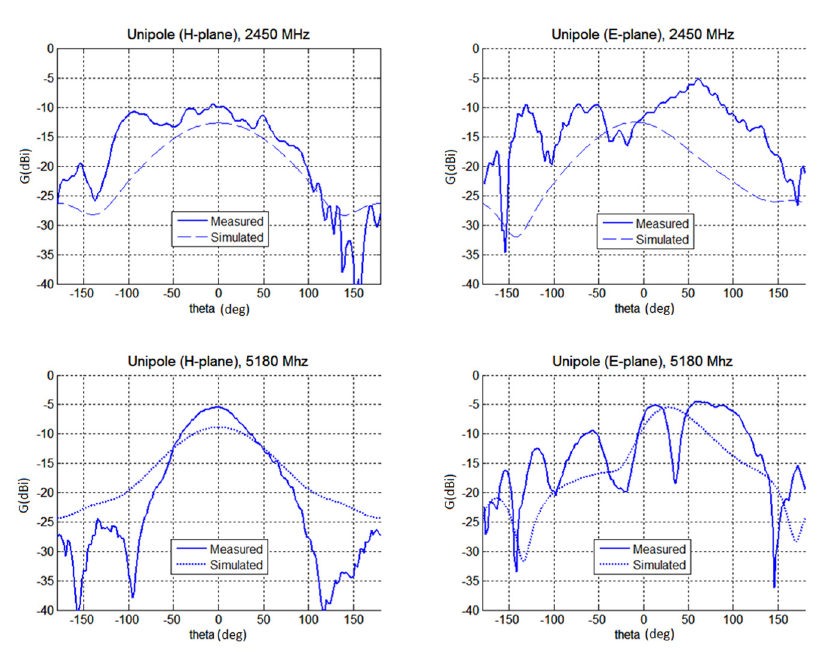
Figure 17. The measured and simualted gain of the unipole antenna (top line, absolute gain for H and E-plane at 2450 MHz, bottom line, absolute gain for H and E-plane for 5180 MHz).